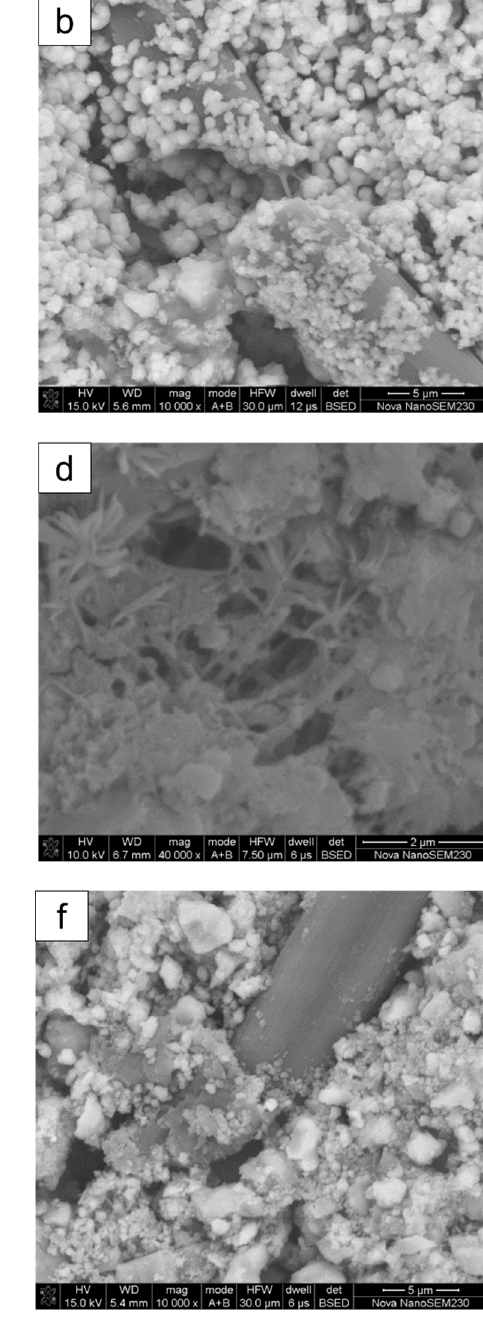
Figure 12. Polymers with different morphologies in the fiber transition zone. ( a ) Granular polymer; ( b ) a 5 × enlargement of ( a ); ( c ) fibrous polymer; ( d ) an 8 × times enlargement of ( b ); ( e ) membranous polymer on exposed fibers; ( f ) membranous polymer at the fiber–matrix interface.